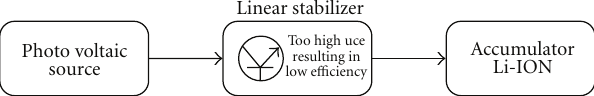
Figure 2: Linear stabilization using bipolar